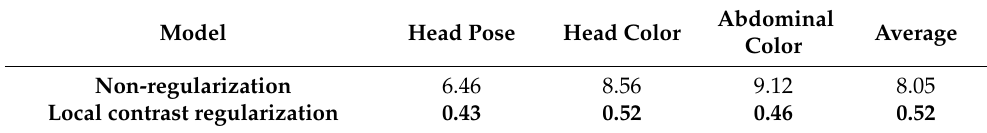
Figure 13. LSUNCat dataset Coat color semantic attribute editing comparison results.